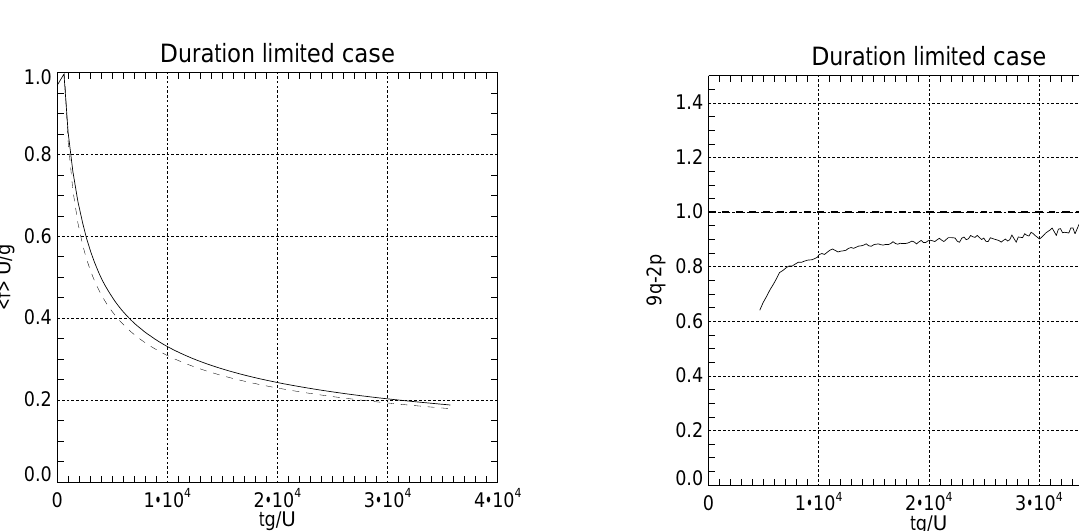
Figure 3. Energy local power function index p = dln E tion of dimensionless time tg/U for the wind speed U = 10ms − 1 duration limited case – solid line. Theoretical value of the self- similar index p = 10 / 7 – thick horizontal dashed line.